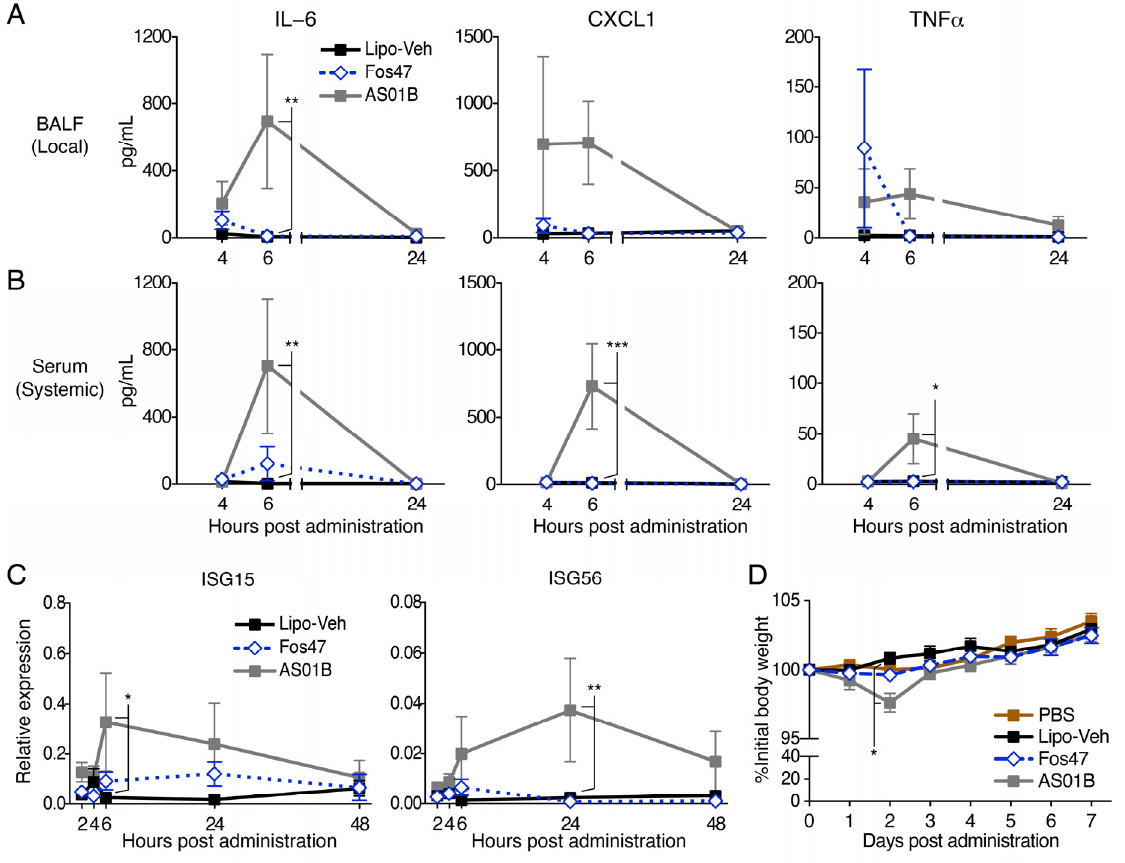
Figure 6. Intranasal delivery of Fos47 demonstrated minimal local and systemic cytokine and chemokine induction. ( A,B ) BALB/c mice (female n = 2–3 and male n = 2–3, total n = 4–6) were IN administered with 25 µ L Lipo-Veh, Fos47 or AS01B. IL-6, CXCL1 and TNF α in BALF ( A ) and serum ( B ) at 4, 6, 24 h were evaluated by Multiplex cytokine assay. ( C ) ISG15 and ISG56 expression in BAL cells were examined at indicated time points (BALB/c mice; female n = 3 and male n = 2–3, total n = 5–6/group). The gene expressions were evaluated by the Quantigene assay and were normalized to the house keeping gene expression of Rpl19 and Rps20. ( D ) Body weight changes after IN administration. Female BALB/c mice ( n = 4/group) were IN administered with 25 µ L PBS, Lipo-Veh, Fos47 or AS01B. %Initial body weights for 7 days are presented. Bars indicate means ± SEM. * p < 0.05, ** p < 0.01, *** p < 0.001, two-way ANOVA with Holm–Sidak’s post hoc test (A–D: vs.